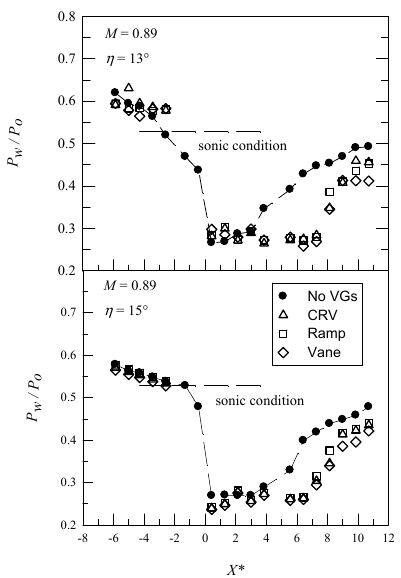
Figure 9. Mean surface pressure distributions for M = 0.89.